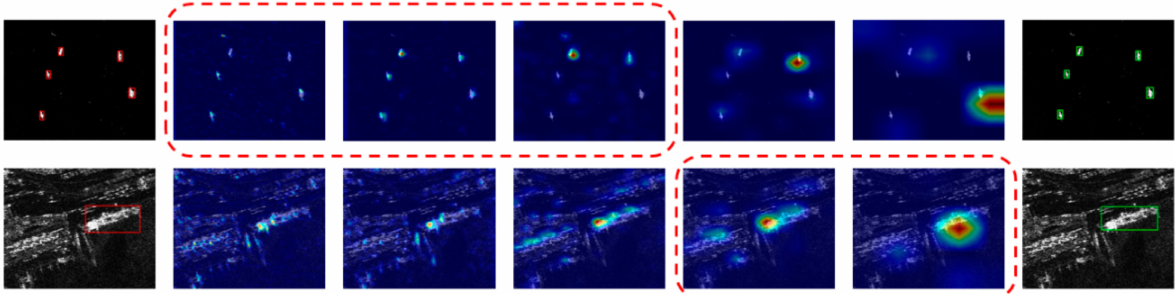
Figure 9. Heatmap is generated, with the leftmost column listed as ground truth, and the 2, 3, 4, 5, and 6 columns corresponding to the output of the multi-scale feature extraction module of TWC-Net from a high scale to a low scale (from shallow to deep), and the last column representing the output of